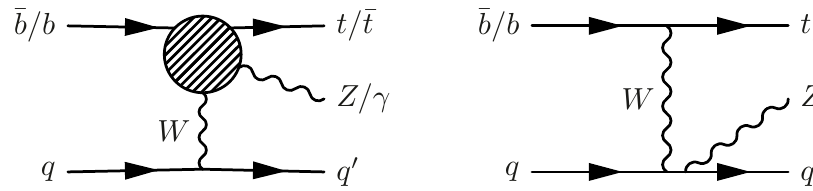
Figure 8. Left : schematic Feynman diagram for the EW-induced tZj / t(cid:13)j processes and the embeddings of the b W t Z and b W t Z subamplitudes. Right : sample Feynman diagram for ! ! the topologies which do not embed the subamplitudes of